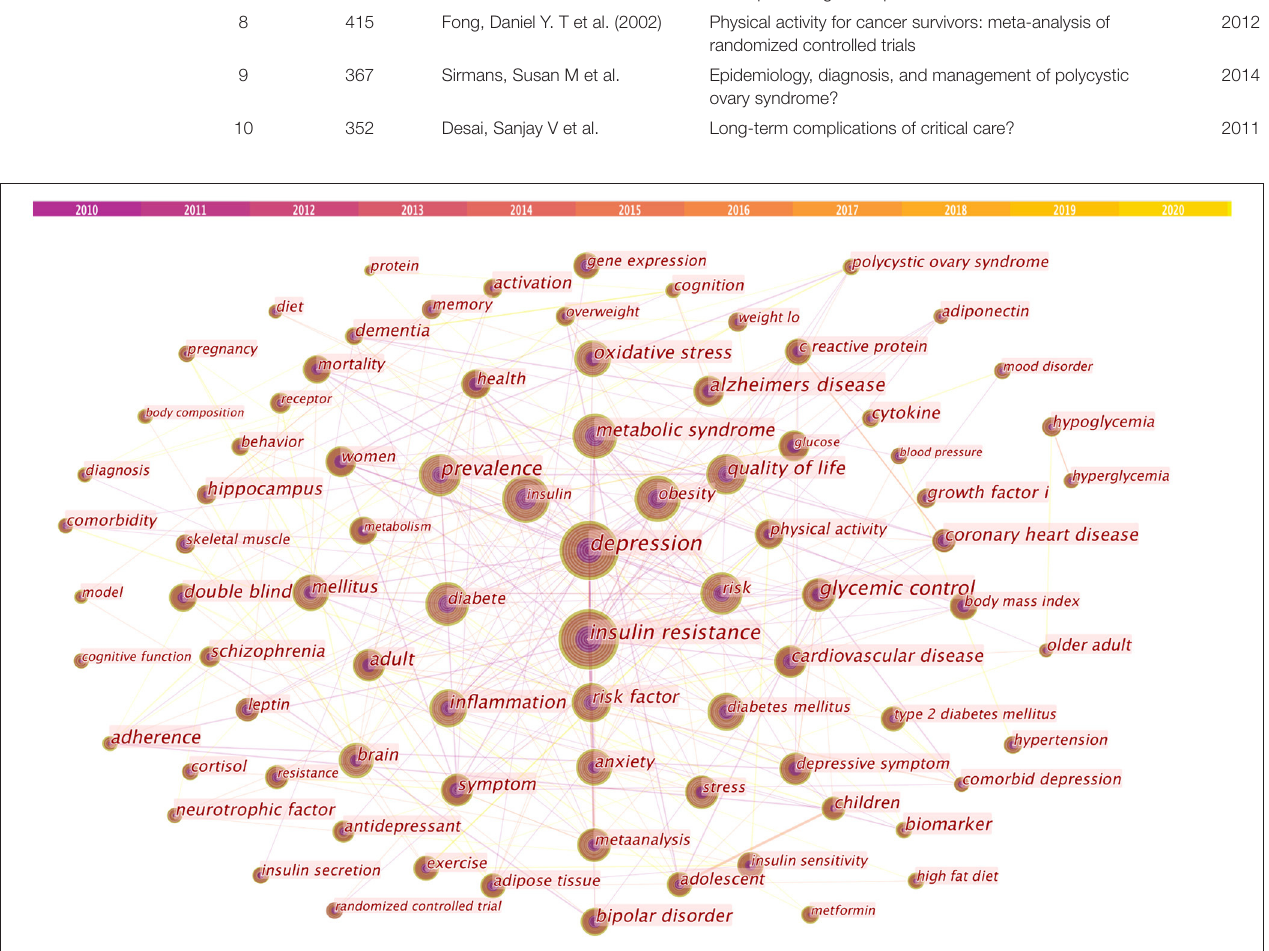
FIGURE 4 | Co-occurring keywords